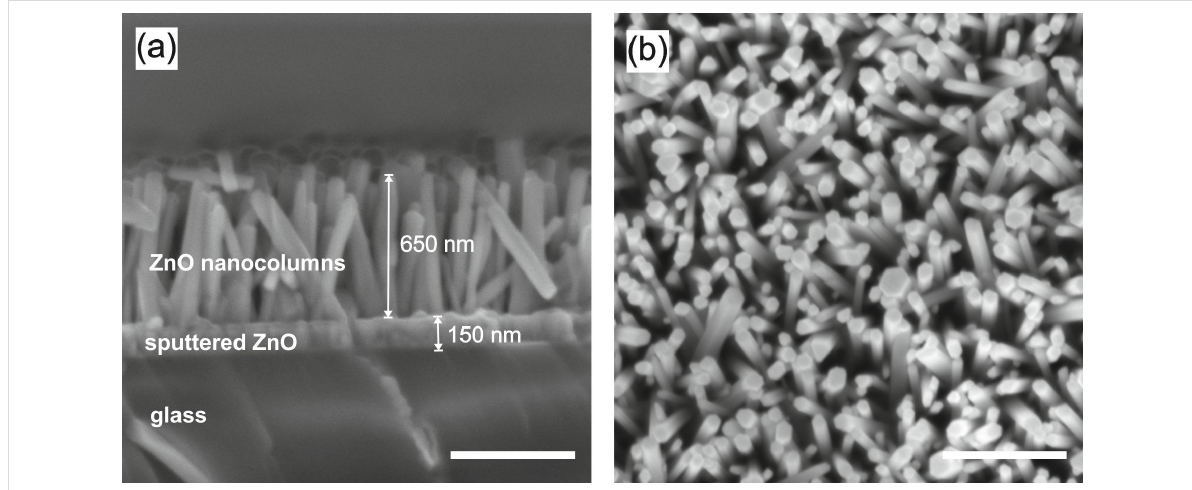
Figure 1: Cross-sectional (a) and top (b) view of densely packed ZnO NCs grown at 90 °C for 180 min (scale bar: 500 nm).